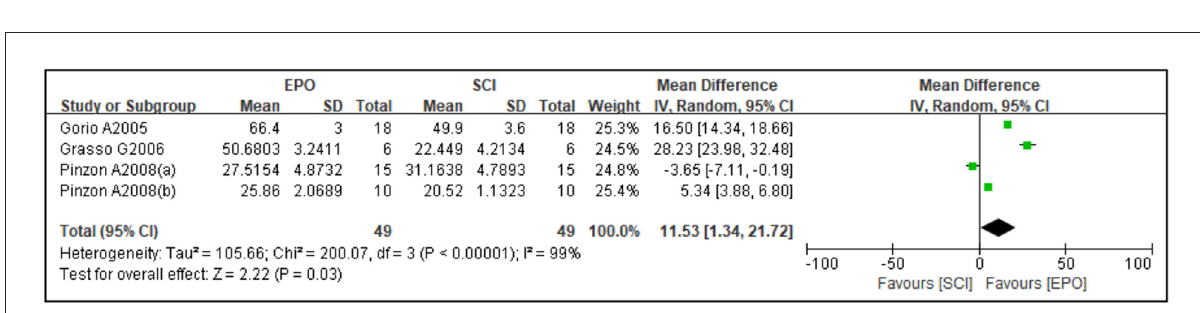
FIGURE4 Forest plot for the effects of EPO intervention on spared area in rats with SCI. EPO, erythropoietin; SCI, spinal cord injury.